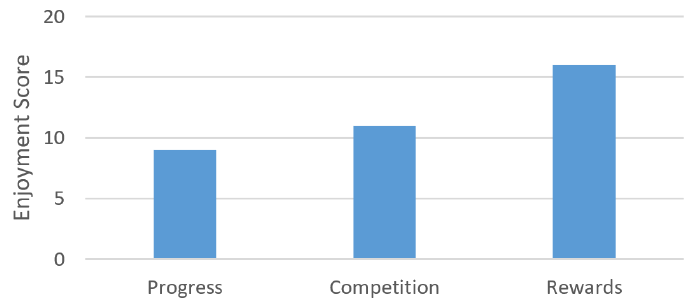
Figure 14. Enjoyment score for each version of